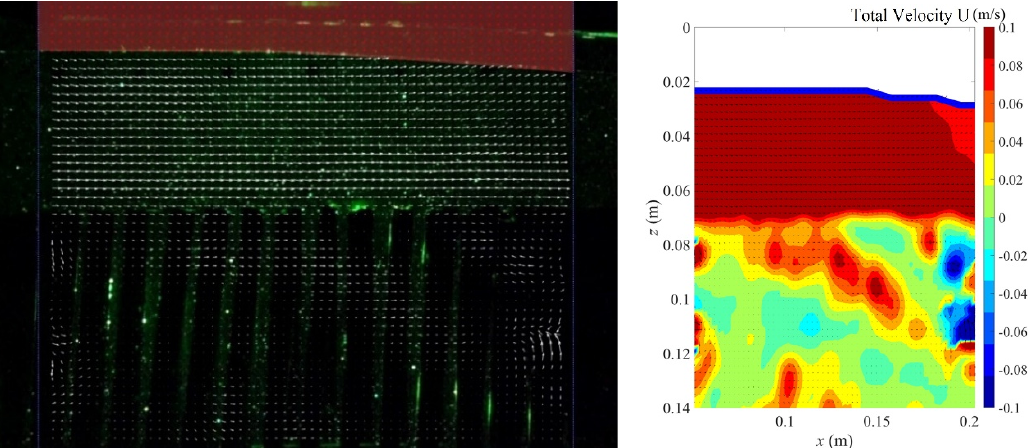
Figure 7. Velocity field and distribution of a long-period wave crest ( T = 2.0 s) passing through vegetation structures ( ϕ = 0.5 cm and d = 10 cm).